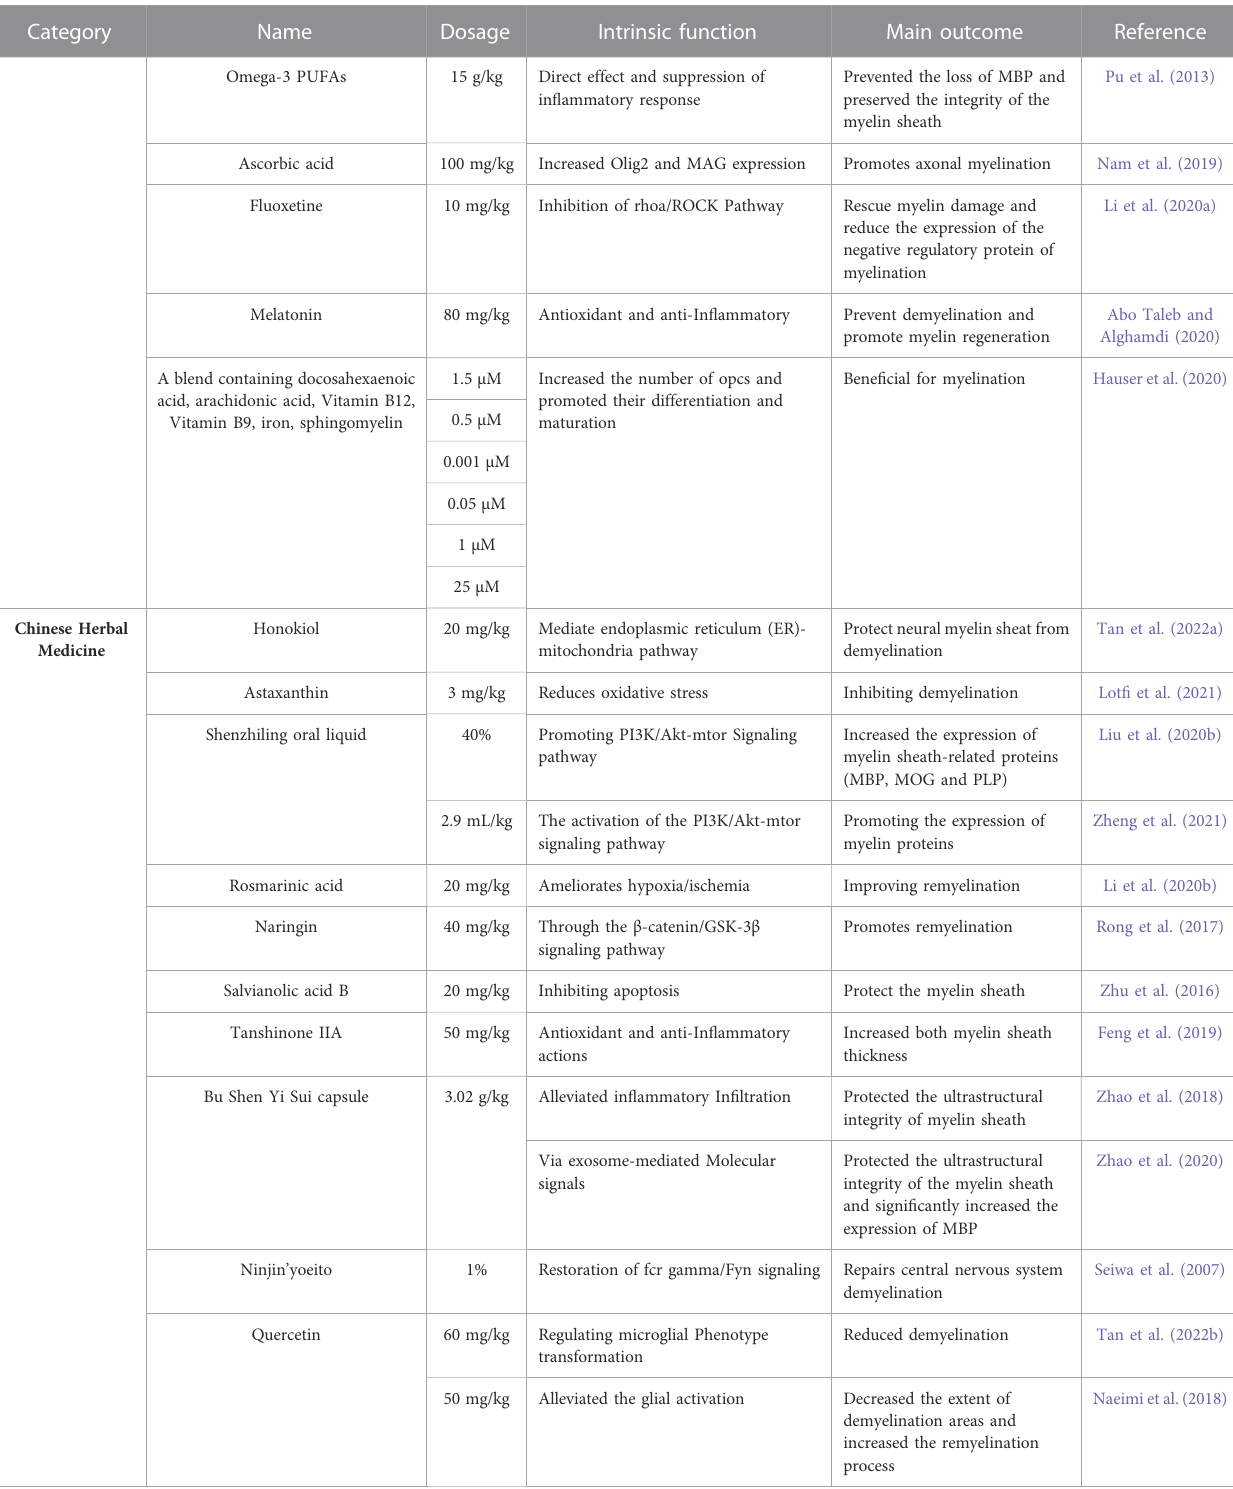
TABLE 2 ( Continued ) Summary of therapeutic drug research on myelin sheath injury caused by other